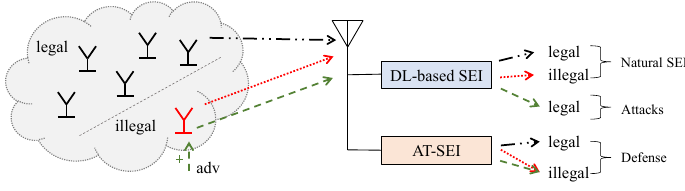
Figure 2. Scheme of DL-based SEI in three